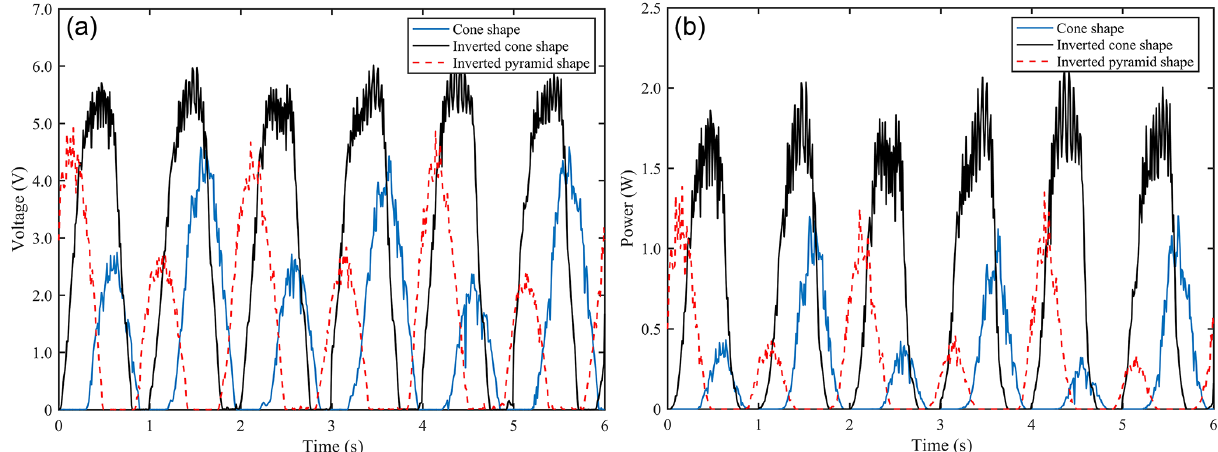
Figure 10. Energy efficiency characteristic curves of the conical and pyramid floating bodies. (a) Voltage curve. (b) Power curve.